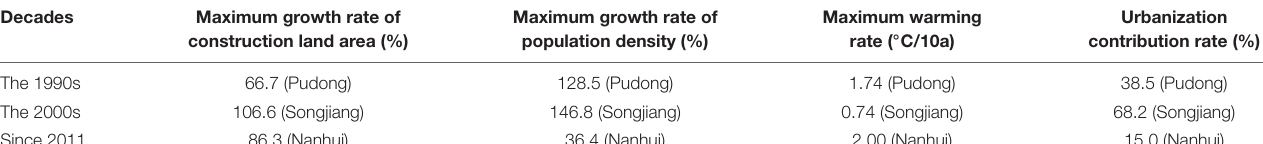
TABLE 2 | The maximum heating rate, urbanization contribution rate, the maximum growth rates of the construction area and population density in each decade.